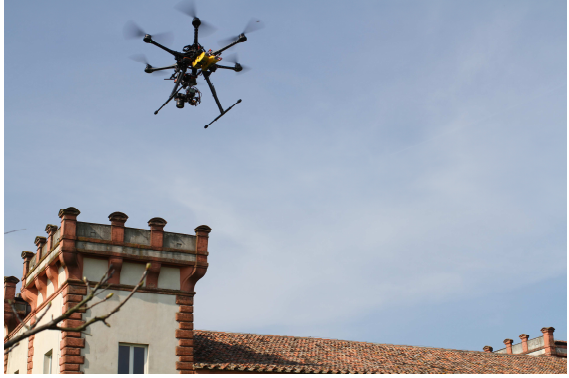
Figure 5. The RPAS flying over the